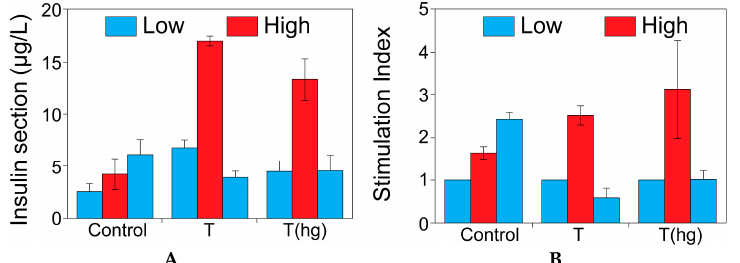
Figure 1. The effect of theophylline on insulin secretion. Insulin secretion (µg/L) ( A ) and stimulation index ( B ) of MIN6 cells cultured on tissue culture plastic (monolayer) without theophylline, with theophylline 10 mM in all the incubation buffers (T), and with theophylline 10 mM added only in the high glucose buffer (T(hg)).